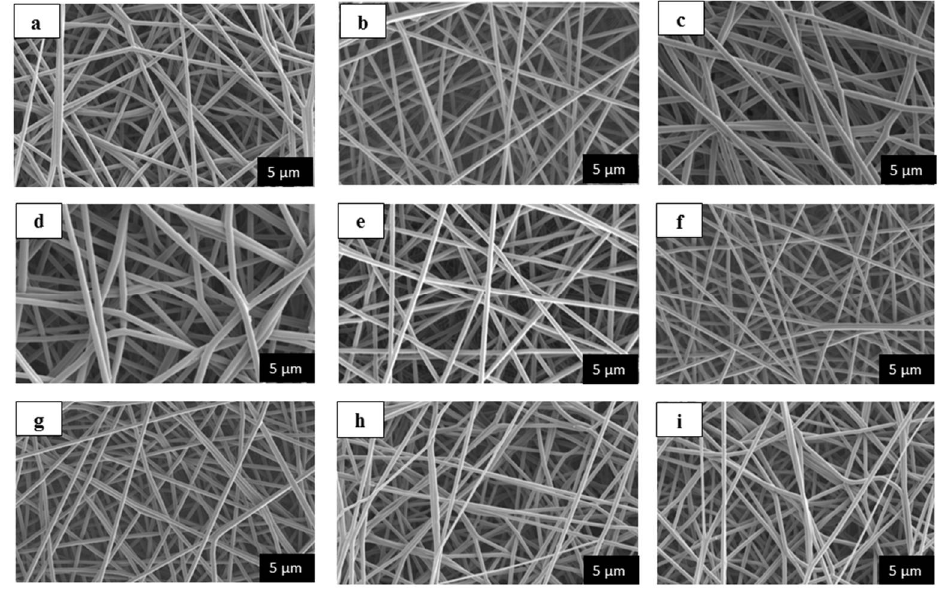
Figure 5. SEM images of W S CHT-PVA nanofibres ( a – i ), produced according to experiment design shown in Table 4.